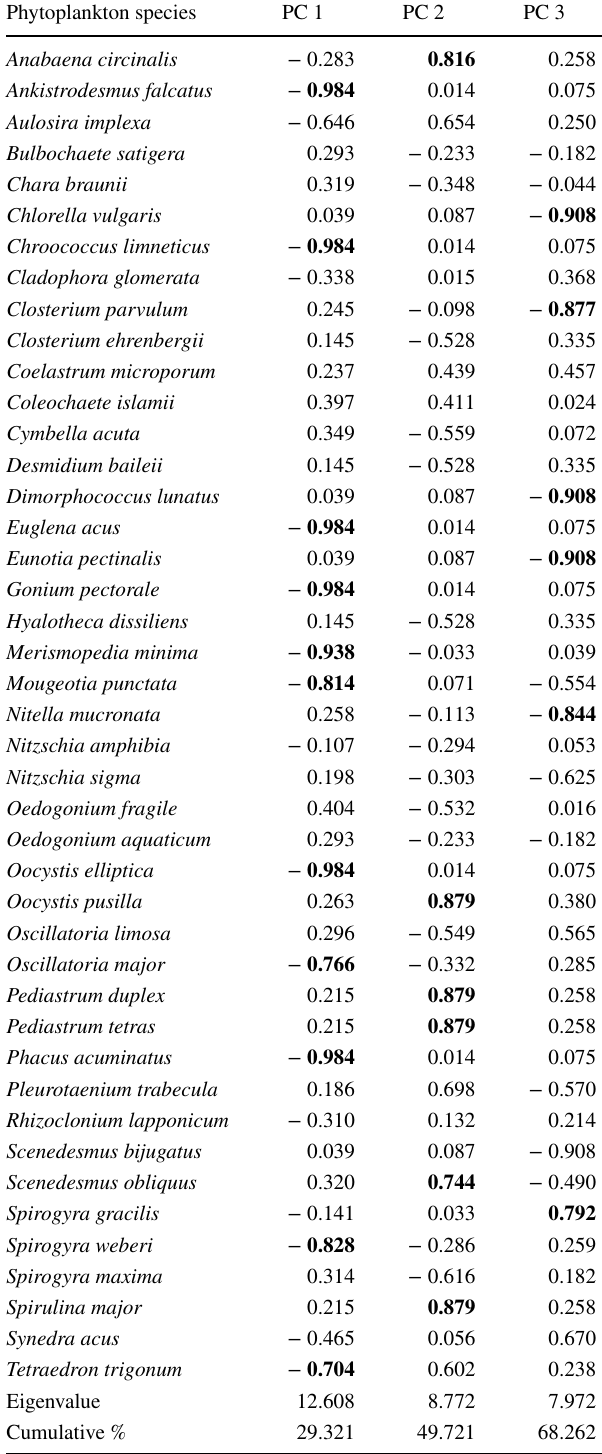
Table 4 Factor loadings of phytoplankton species from seven